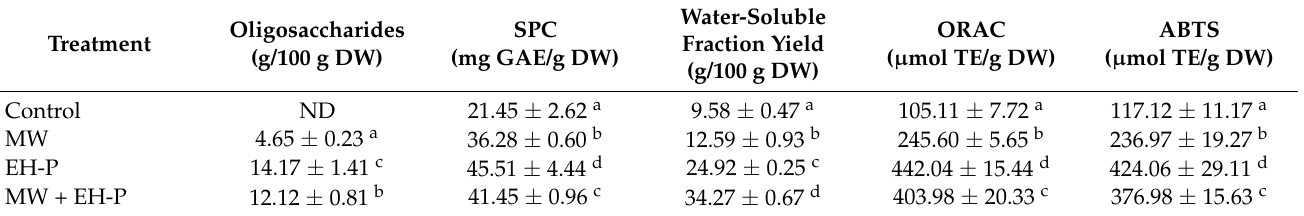
Table 3. Effect of MW, EH-P and MW + EH-P on oligosaccharides, soluble phenolics, soluble water fraction yields and antioxidant activity of lentil